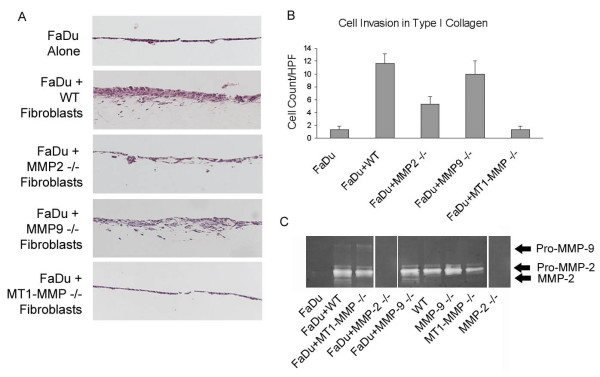
Decreased tumor cell invasion induced by MMP-2 and MT1-MMP null fibroblasts in vitro. The human FaDu HNSCC tumor cell line was cultured alone or in combination with WT, MMP-2 null, MMP-9 null, or MT1-MMP null fibroblasts atop type I collagen for 6 days (A, and quantified in B). Experiments were conducted in DMEM with 10% WT, MMP-2 null or MMP-9 null serum. Gelatin zymography of 18-hour serum free conditioned media from FaDu tumor cells in coculture with fibroblasts atop collagen (2:1 ratio) normalized for cell-number.